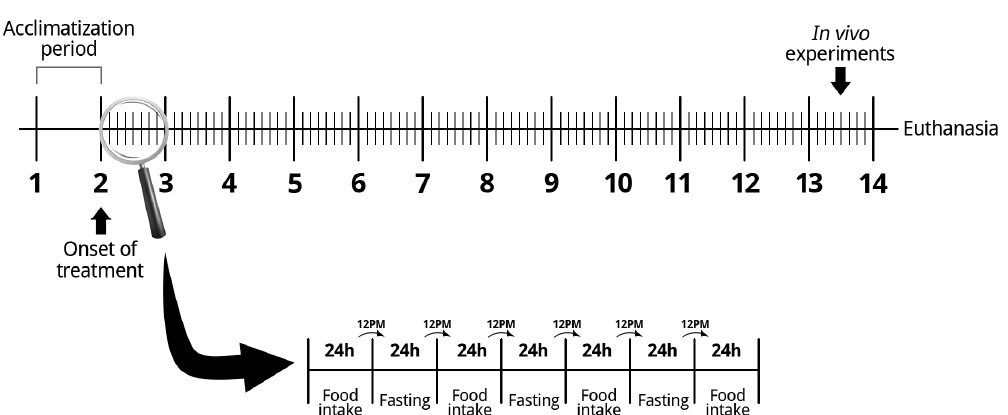
Figure 1. Scheme of the intermittent fasting protocol used.